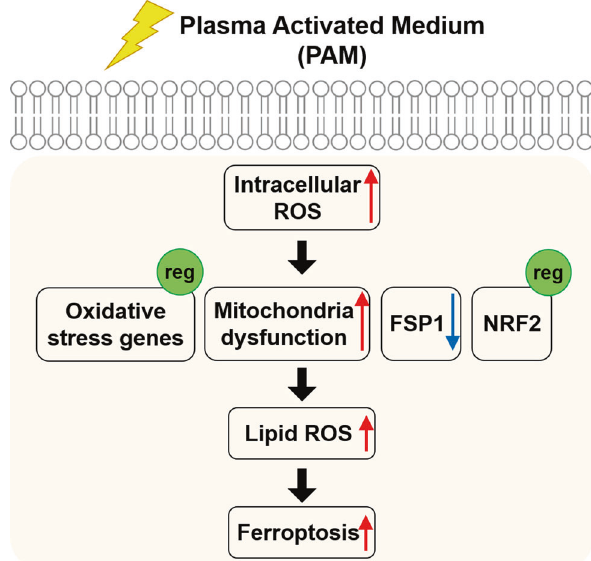
Fig. 6 Ferroptosis pathway scheme upon PAM treatment. The schematic description shows the biological impact of PAM on human lung cancer cells. PAM-induced intracellular ROS triggers oxidative stress genes regulation, mitochondria dysfunction, and control of FSP1/NRF2 expression. Subsequently, upregulation of lipid ROS levels ultimately induce